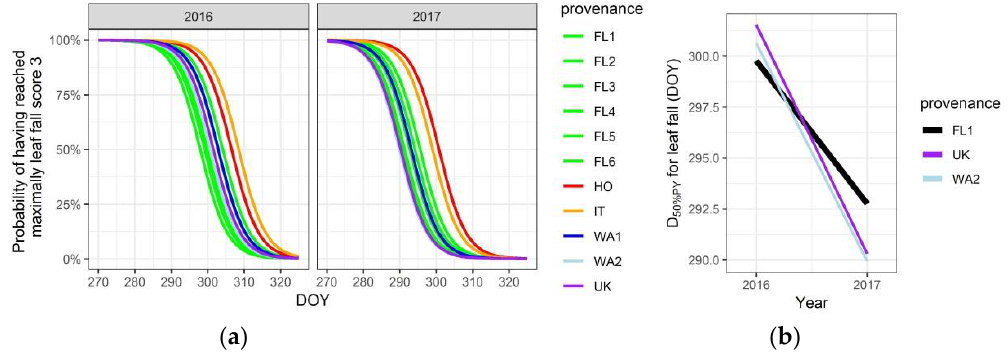
Figure 5. Modeled timing of leaf fall for the different provenances in 2016 and 2017: ( a ) Modeled probability of having reached a maximal leaf fall score of three; ( b ) D 50% PY values for the provenances ( P ) with a significant interaction term in de model statistics, for the years ( Y ) 2016 and 2017. D 50% PY values indicate the modelled DOY when half of the plants of a provenance attain a maximal leaf fall score of three.